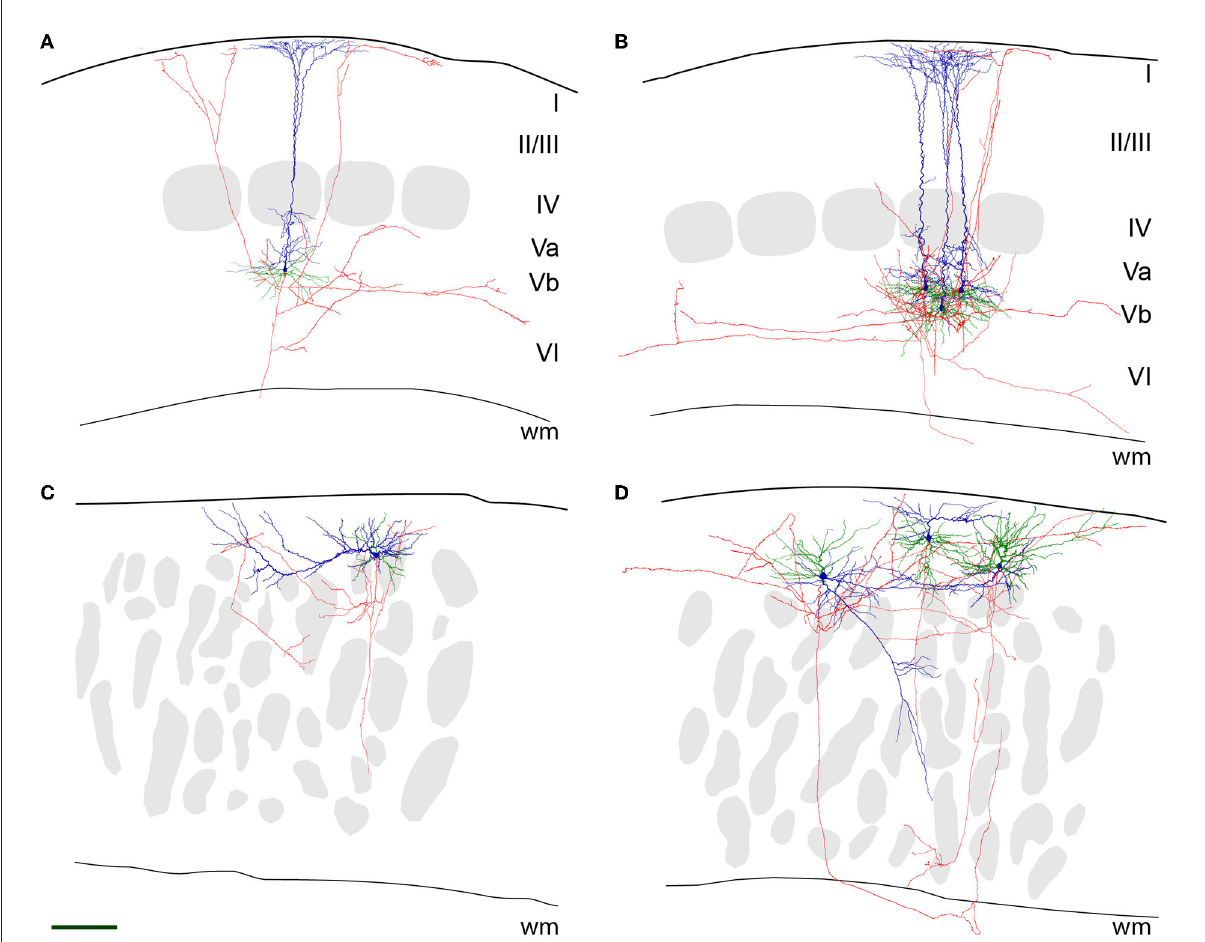
FIGURE3 Neurolucida reconstructions of (LVb) repetitively burst-spiking (RB) pyramidal cells. Representative examples for RB pyramidal cells in LVb of WT (A,B) and close to the pial surface in reeler (C,D) mice. The pial surface and white matter (wm) border are delineated by a thicker and a thinner black line, respectively. Soma and apical dendrite is represented in blue, basal dendrite in green, and axon in red. Gray patches in (A,B) are barrels, and in (C,D) barrel equivalents (see also Figure 2). Scale bar: 150 µ m. (A) A single RB cell and (B) three superimposed RB cells of WT mice are shown. As is typical for these cells, the large soma emits an apical dendrite with oblique side branches toward the pial surface, which starts to form a terminal tuft as early as in LIV. Basal dendrites originate at the opposite pole of the soma and spread out (semi-)radially. The axon runs toward the white matter and gives off recurrent collaterals that either ascend to LI or prefer a horizontal to an oblique direction in the infragranular layers. (C) A single RB cell and (D) three superimposed RB cells of reeler mice are shown. Note that in (C), the apical dendrite has a horizontal whereas in (D) , from left to right) an oblique, another horizontal and an “upright” orientation can be seen. The segregation from the basal dendrites is much less clear. Note that the axons by and large prefer horizontal directions in the compartment being located between the pial surface and the barrel